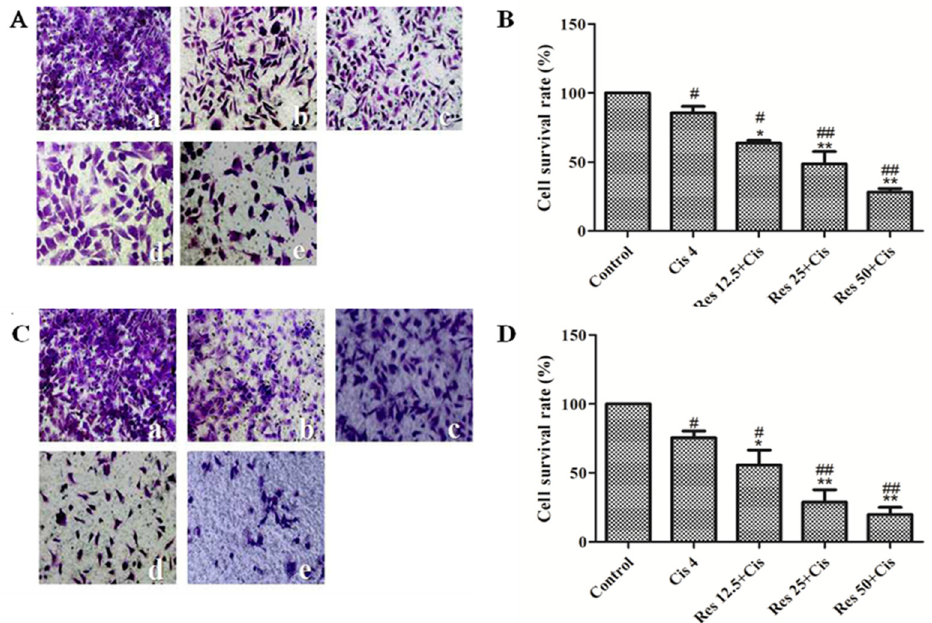
Figure 2. Effects of resveratrol combined with cisplatin on the migration and invasion of MDA231 cells. Transwell chamber migration and invasion experiments ( × 200). ( A ) Transwell chambers images of cell migration; ( B ) cell migration rate; ( C ) transwell chambers images of cell invasion; ( D ) cell invasion rate. (a) Control group; (b) 4 μ M cisplatin group; (c) 12.5 μ M resveratrol + 4 μ M cisplatin group; (d) 25 μ M resveratrol + 4 μ M cisplatin group; (e) 50 μ M resveratrol + 4 μ M cisplatin group. # vs. control group; * vs. cisplatin group. */# p < 0.05, **/## p < 0.01, vs. the control group. Error bars represent three independent experiments, each performed three times.